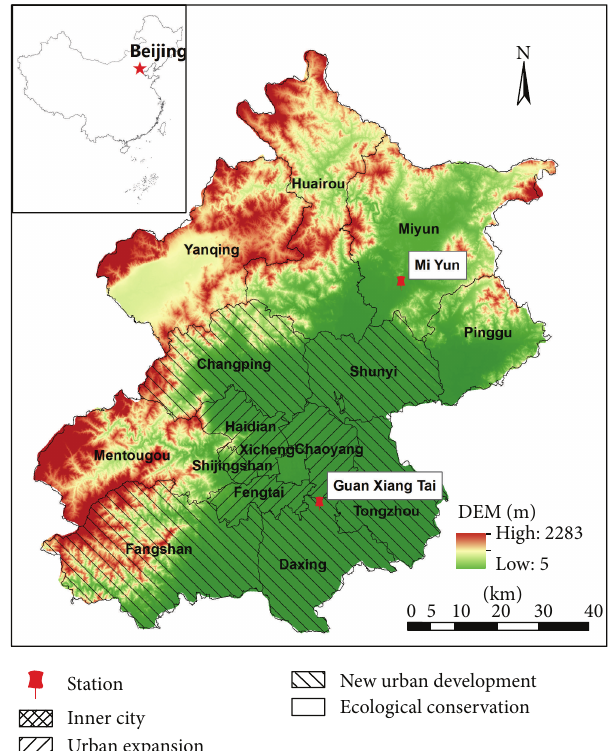
Figure 1: The districts, counties, and meteorological stations of